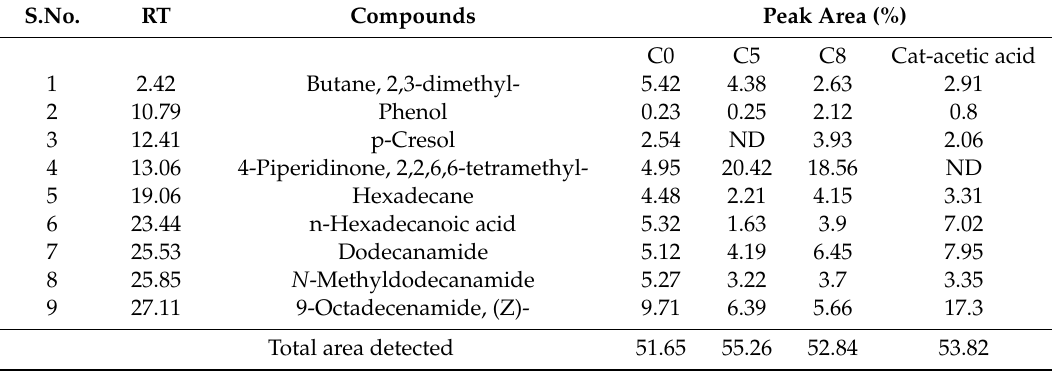
Table 6. The major organic compounds detected in bio-crude at di ff erent